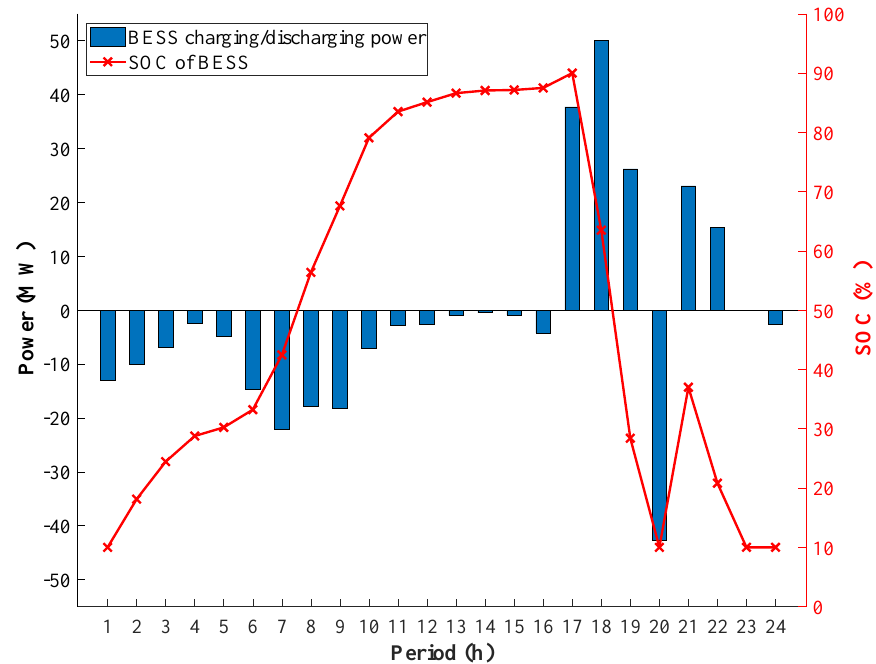
Figure 10. Behavior of BESS at bus 7 in Case 2.